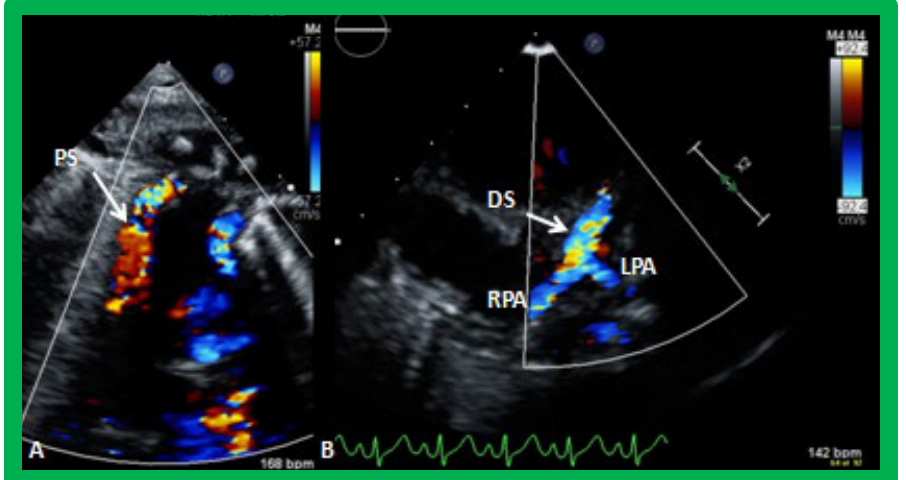
Figure 19. Selected video frames from suprasternal notch view demonstrating proximal shunt (PS) by color flow imaging ( A ). In a slightly different view, ( B ), the flow from the distal shunt (DS) into right (RPA) and left (LPA) pulmonary arteries is shown.